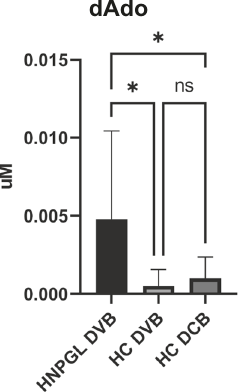
Fig. 5 Comparison of dAdo levels in dried venous blood (DVB) versus dried capillary blood (DCB) from head and neck para- ganglioma (HNPGL) patients and healthy controls (HCs). Statisti- cally signi fi cant differences were observed between the DVBs from the HNPGL patients and the DVBs from the HCs. The levels of dAdo in the DVBs and paired DCBs from the HCs were comparable. Signi fi cance was established by ANOVA (HNPGLs: 21 cases; DVBs from HCs: 9 cases; DCBs from HCs: 16 cases) (* p <